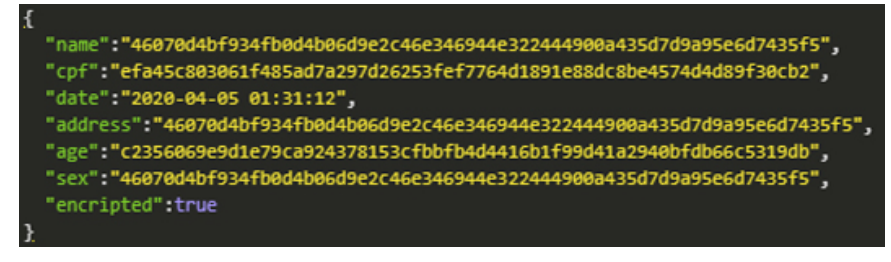
Figure 12. AES Encryption.